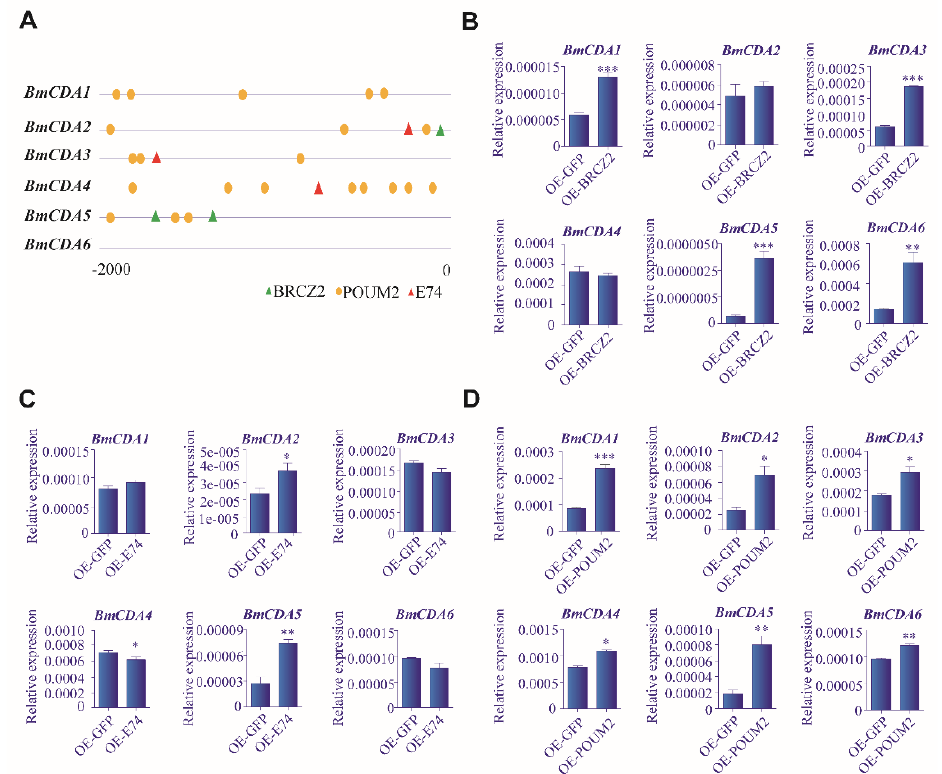
Figure 7. ( A ) Arrangement of the predicted cis-regulatory elements (CREs) in the promoter regions of BmCDA1 – 6 . The potential CREs are predicted by MatInspector [33]. ( B – D ) Overexpression of BRC-Z2, E74, and POUM2 in Bombyx mori embryonic ( Bm E) cells. Overexpression of ( B ) BRC-Z2, ( C ) E74, and ( D ) POUM2 in Bm E cells (OE-BRCZ2, OE-E74, and OE-POUM2) for 72 h, followed by RT-qPCR analysis of Bombyx mori chitin deacetylases ( BmCDAs ) gene expression. Overexpression of green fluorescent protein (OE-GFP) was used as the control; error bars represent the standard error of mean (SEM) from three replicates. * p < 0.05, ** p < 0.01, *** p < 0.001 vs. control.